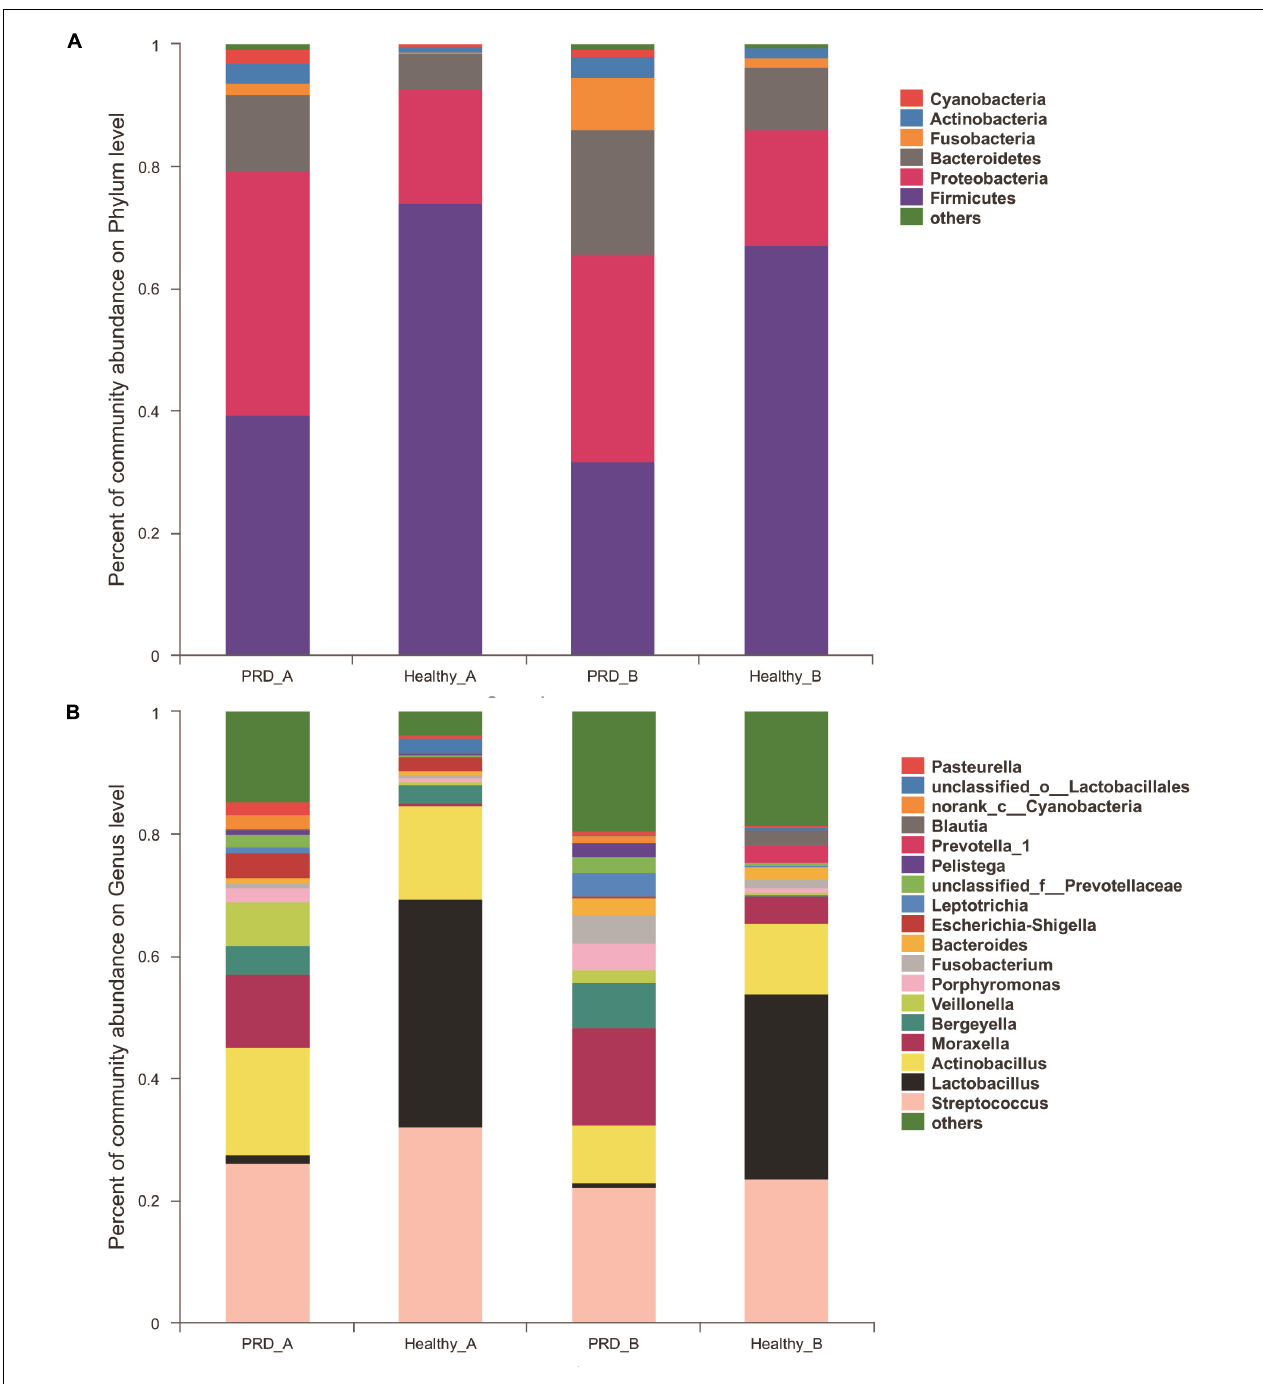
FIGURE 3 | Community bar-plot analysis shows relative abundance of sequences at the (A) phylum and (B) genus levels observed in PRD and healthy groups in farm A and farm B. OTUs comprising less than 1 and 2% at the phylum and genus level of the total abundance are represented as others.